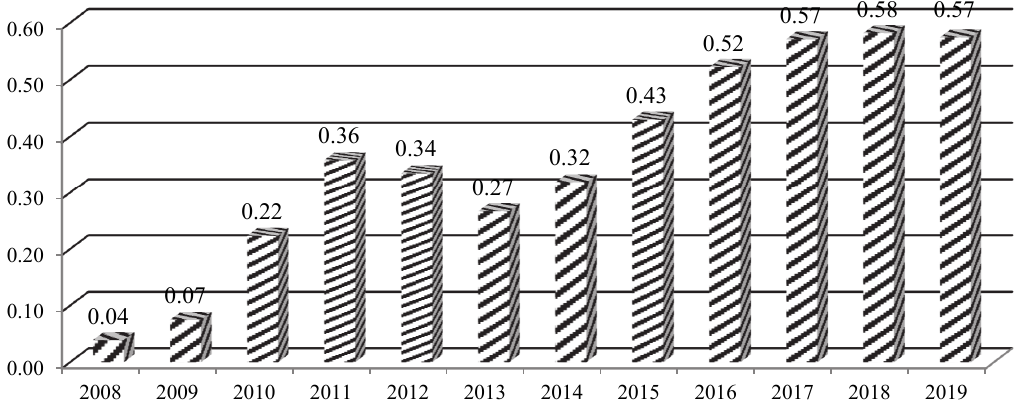
Fig. 1. Dynamics of the integrated indicator change of the information security level of Ukraine during 2008-2019 Source: own